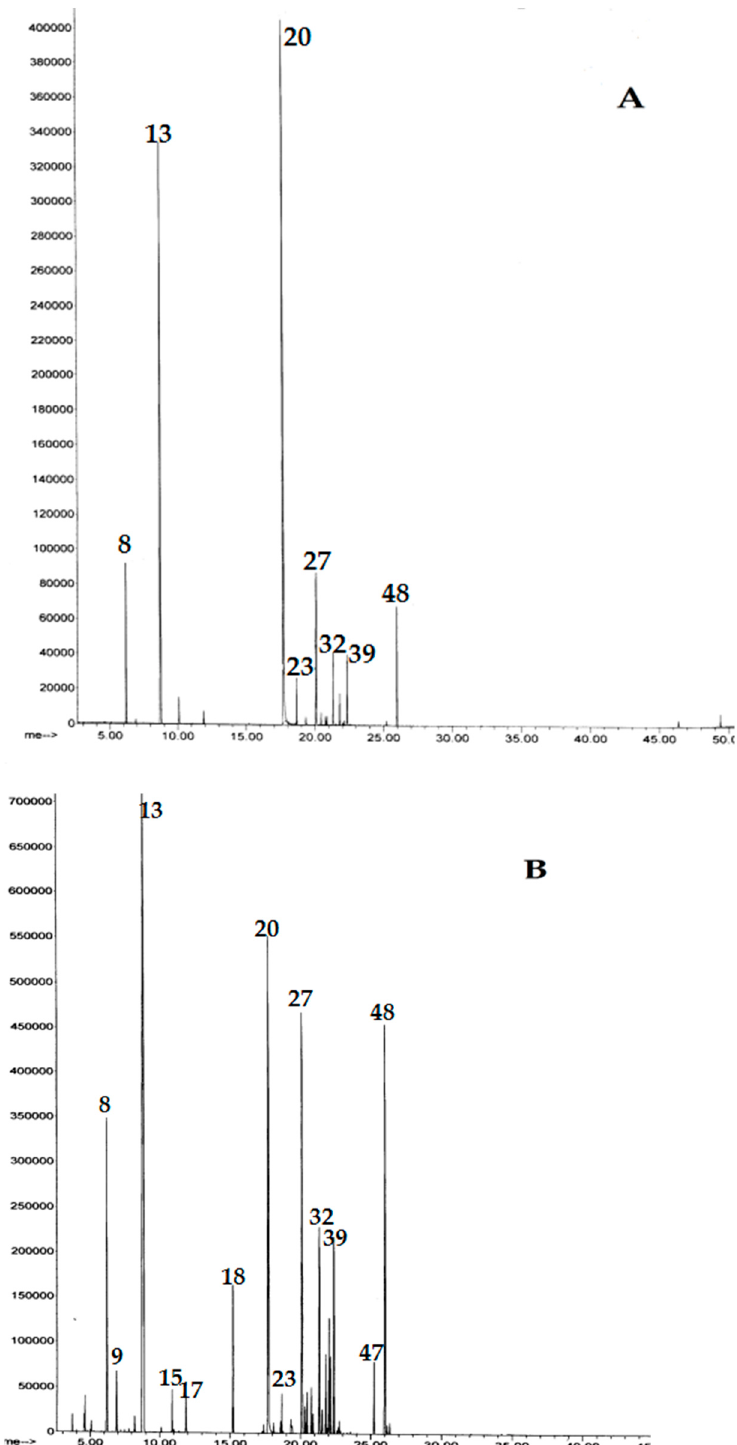
Figure 1. Chromatographic profiles of O. basilicum VOC ( A ) and LEO ( B ). The numbers correspond to the compounds detected as described in Table 1.